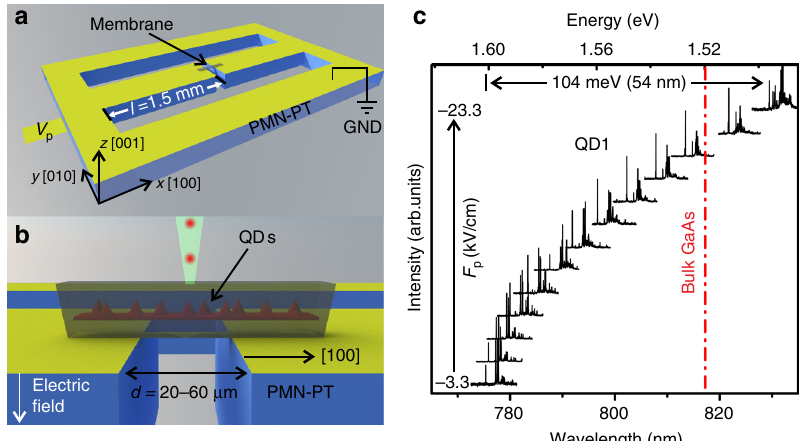
Fig. 2 Experimental con fi guration and emission energy tuning of a GaAs QD via uniaxial stress provided by a micro-machined PMN-PT actuator. a Sketch of the actuator featuring two fi ngers with length l separated by a gap of width d . A semiconductor membrane with embedded QDs is bonded on the fi ngers and forms a bridge above the gap. V p is the voltage applied to the bottom of the PMN-PT actuator with respect to the top contact, which is grounded. Because of the chosen poling direction, a negative electric fi eld F p across the PMN-PT induces a contraction of the fi ngers and uniaxial tensile stress in the semiconductor along the x direction. The coordinate system is the same as for the (Al)GaAs crystal. b Side-view of the device. PL measurements are performed by exciting and collecting PL along the z axis. c Normalized PL spectra of a GaAs QD measured for increasing uniaxial tensile stress (from bottom to top). The large tuning range leads to emission below the bandgap of unstrained bulk GaAs (dashed